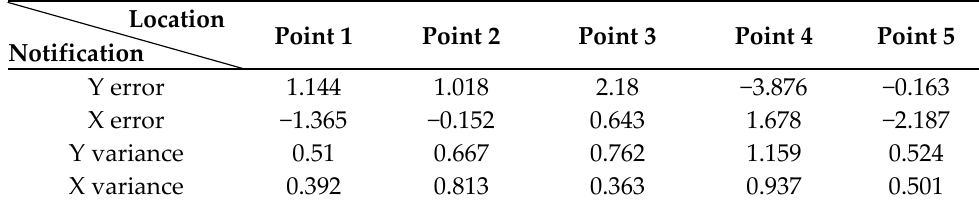
Table 9. Mean positioning error and variance, Nano 33, BLE 5.0.